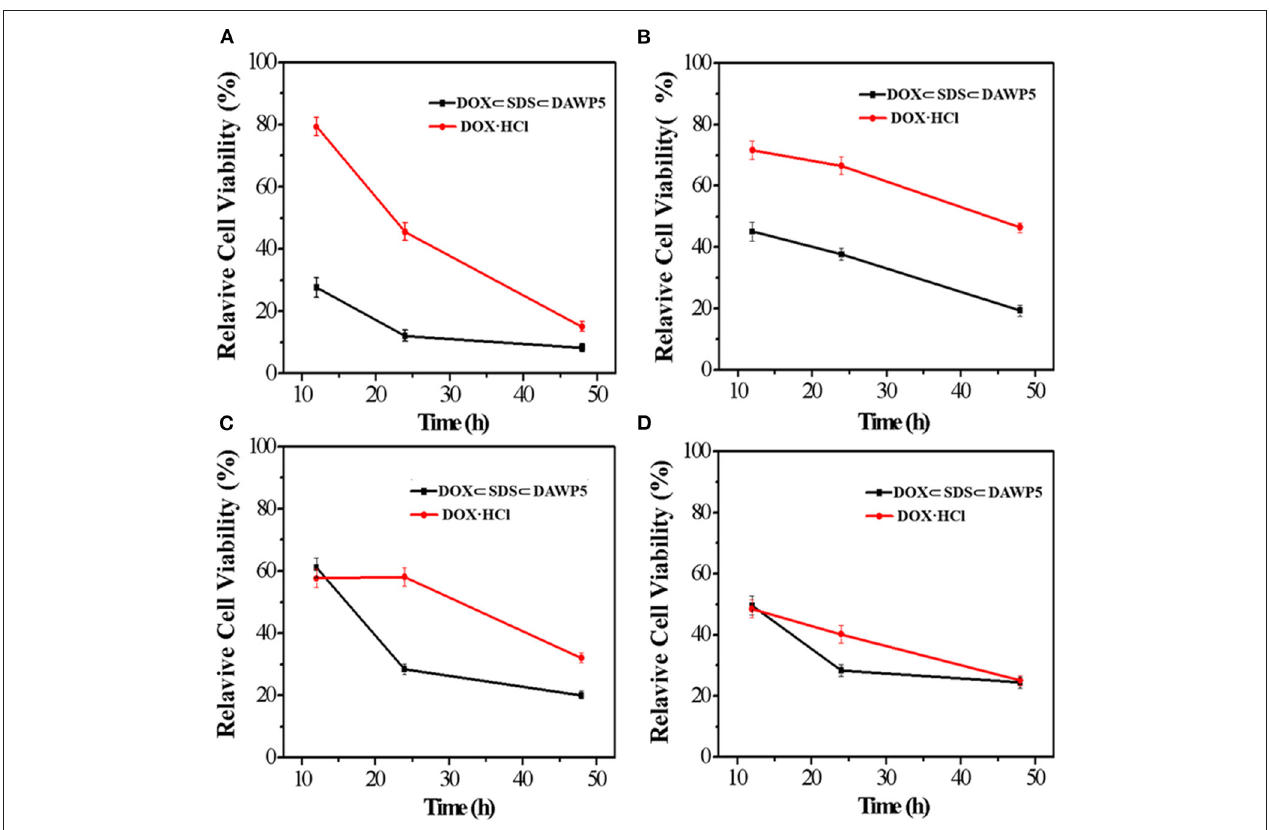
FIGURE 5 | In vitro cytotoxicities of DOX-loaded vesicles and free DOX against (A) HeLa, (B) HepG2, (C) MGC-803, and (D)